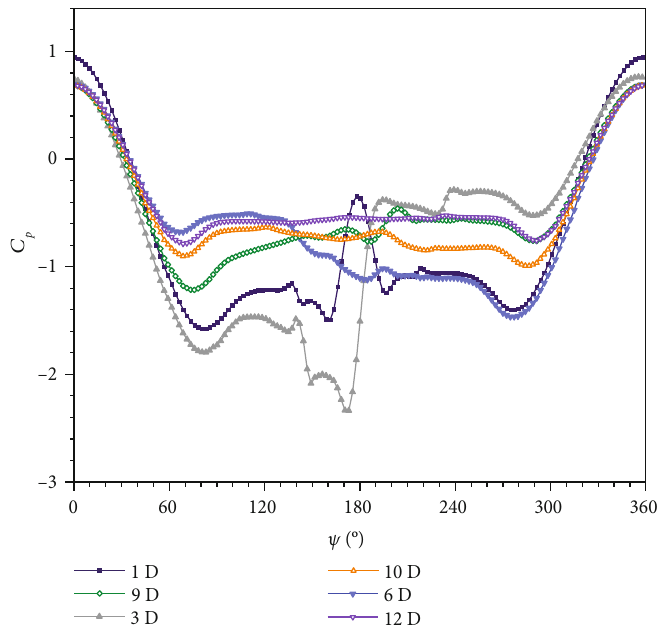
Figure 43: The pressure coe ffi cient of di ff erent sections varies with the roll angle at Model 3 with R a = 5 μ m.